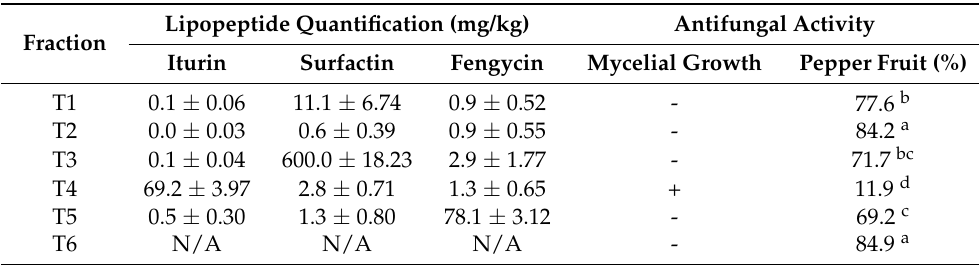
Values represent the means of peak heights for standards measured by LC-MS/MS. T1–T5, Fractions isolated from strain KB21; T6, water control; N/A; not available. Data are means ± SE of three replicates. The